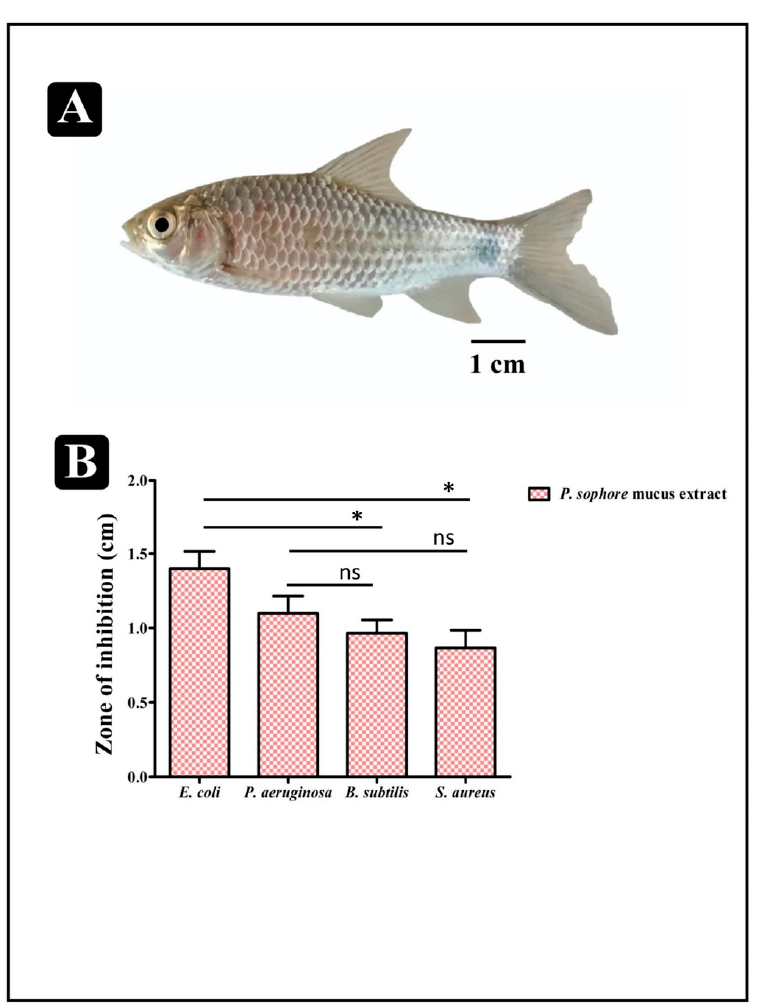
Figure 1. Puntius sophore and its antibacterial activity. ( A ) Puntius sophore ( B ) antibacterial activity against E. coli , P. aeruginosa, B. subtilis , and S. aureus . All experiments were carried out in triplicate, and data represent the mean ± SD. Statistical significance between different groups was determined using Student’s t -test (* p < 0.05).